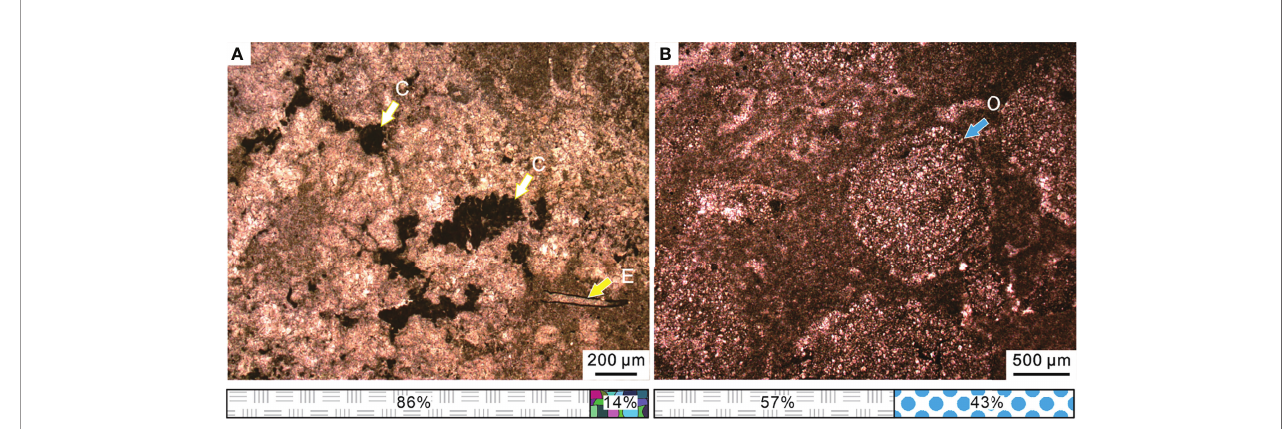
FIGURE 9 | (A) Spherical calci fi ed cyanobacteria and small foraminifera Earlandia sp. of the microbialite from Bed 3 in the Chongyang section. (B) Micropetrologic characters of Bed 5 in the Chongyang section, including poorly sorted ooids within the micrite matrix. The legend is consistent with that of Figure 4 . C, cyanobacteria; E, Earlandia sp.; O, ooids.